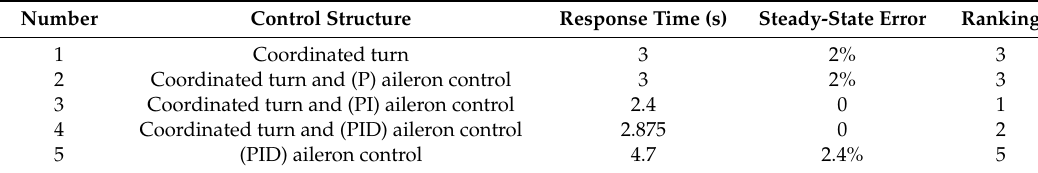
Table 6. Summary of UAV design and performance characteristics.